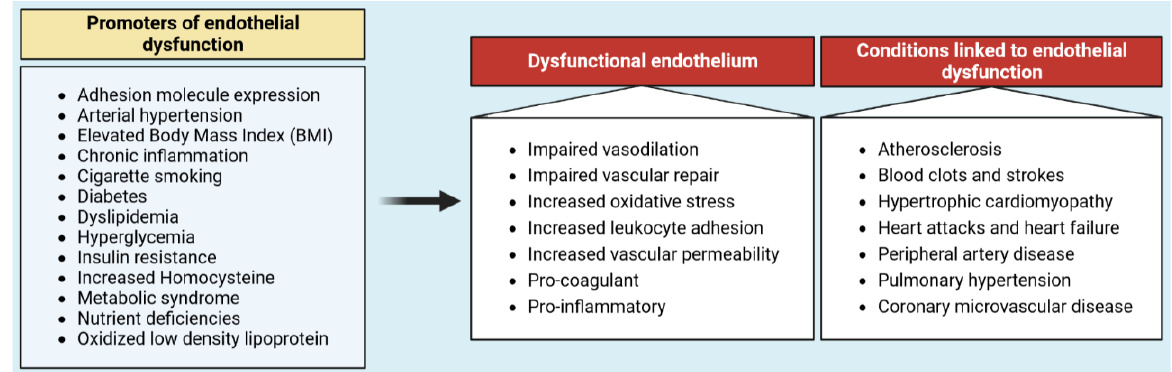
Figure 2. Major promoters of endothelial dysfunction and its associated conditions.